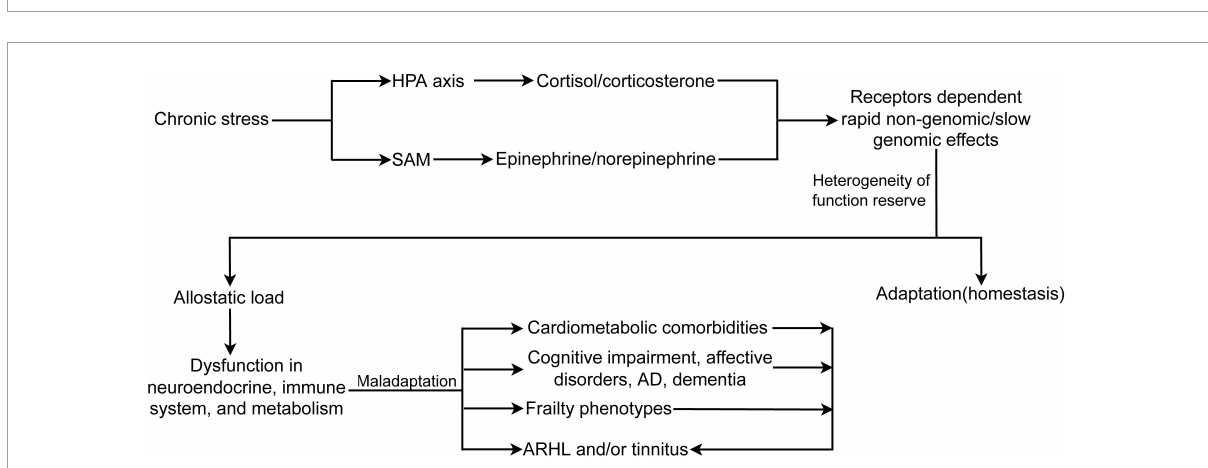
FIGURE2 Chronic stress activates HPA axis and SAM, induces receptors dependent rapid non-genomic/slow genomic effects, and allostatic load, which causes dysfunction in neuroendocrine and immune system, and metabolic abnormality. In turn, allostatic load leads to different frailty phenotypes, comorbidities, and ARHL and/or tinnitus. Moreover, frailty phenotypes and comorbidities also can cause or exacerbate ARHL and/or tinnitus. HPA, hypothalamus-pituitary-adrenal axis; SAM, sympathetic adrenal–medullary axis; AD, Alzheimer disease; ARHL, age-related hearing